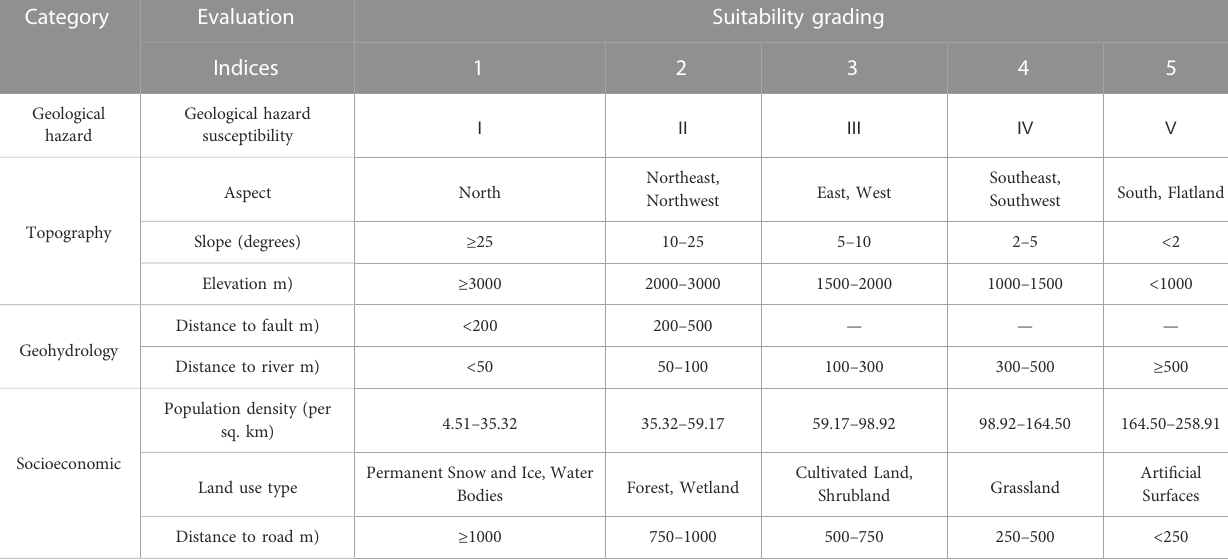
TABLE 1 Suitability evaluation index system and grading criteria.